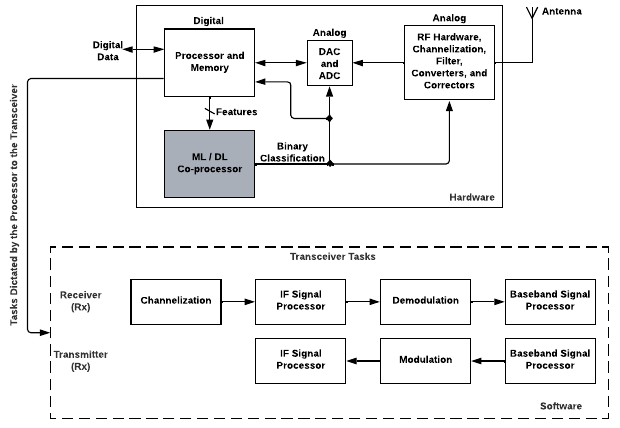
Figure 2. Proposed radio system based on SDR and the ML/DL